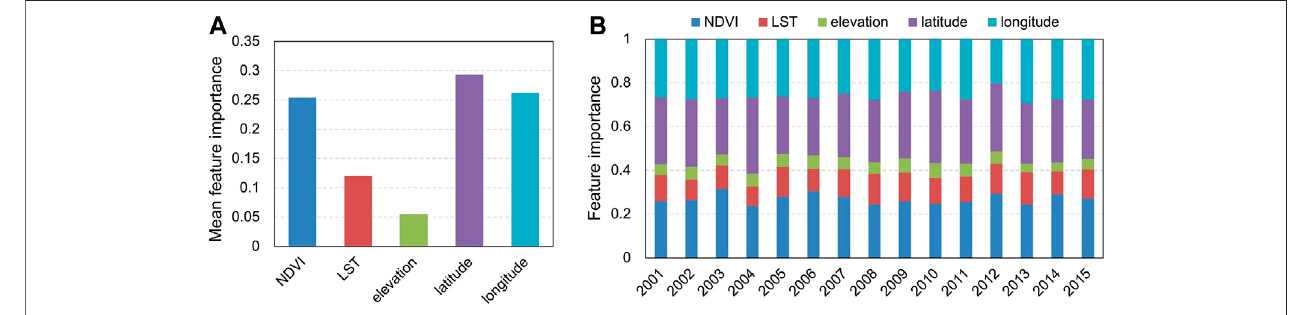
FIGURE 4 | Feature importance in the RF downscaling method: (A) mean feature importance; (B) feature importance for each year.